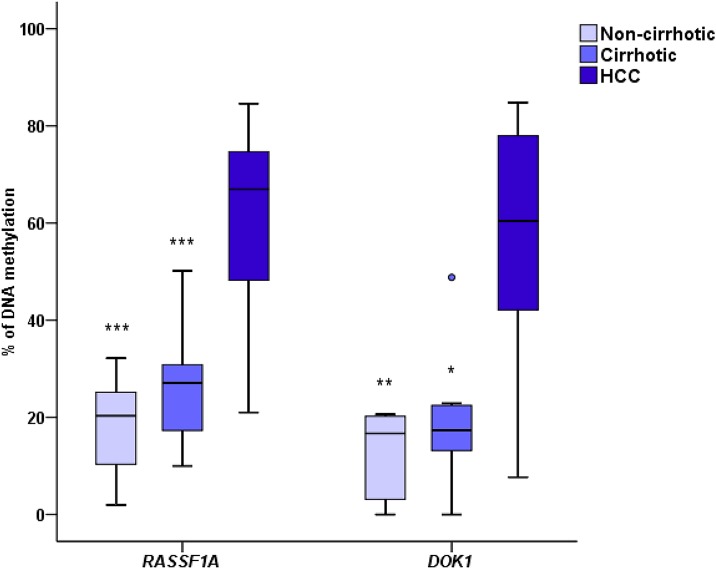
Boxplot showing RASSF1A and DOK1 promoter methylation levels in non-cirrhotic, cirrhotic, and HCC tissues.Methylation levels were measured by pyrosequencing at different CpG sites and expressed as the mean percentage of all CpGs analyzed at a given gene. The statistical significance for DNA methylation level in non-cirrhotic and cirrhotic tissues was calculated by comparison to HCC samples.